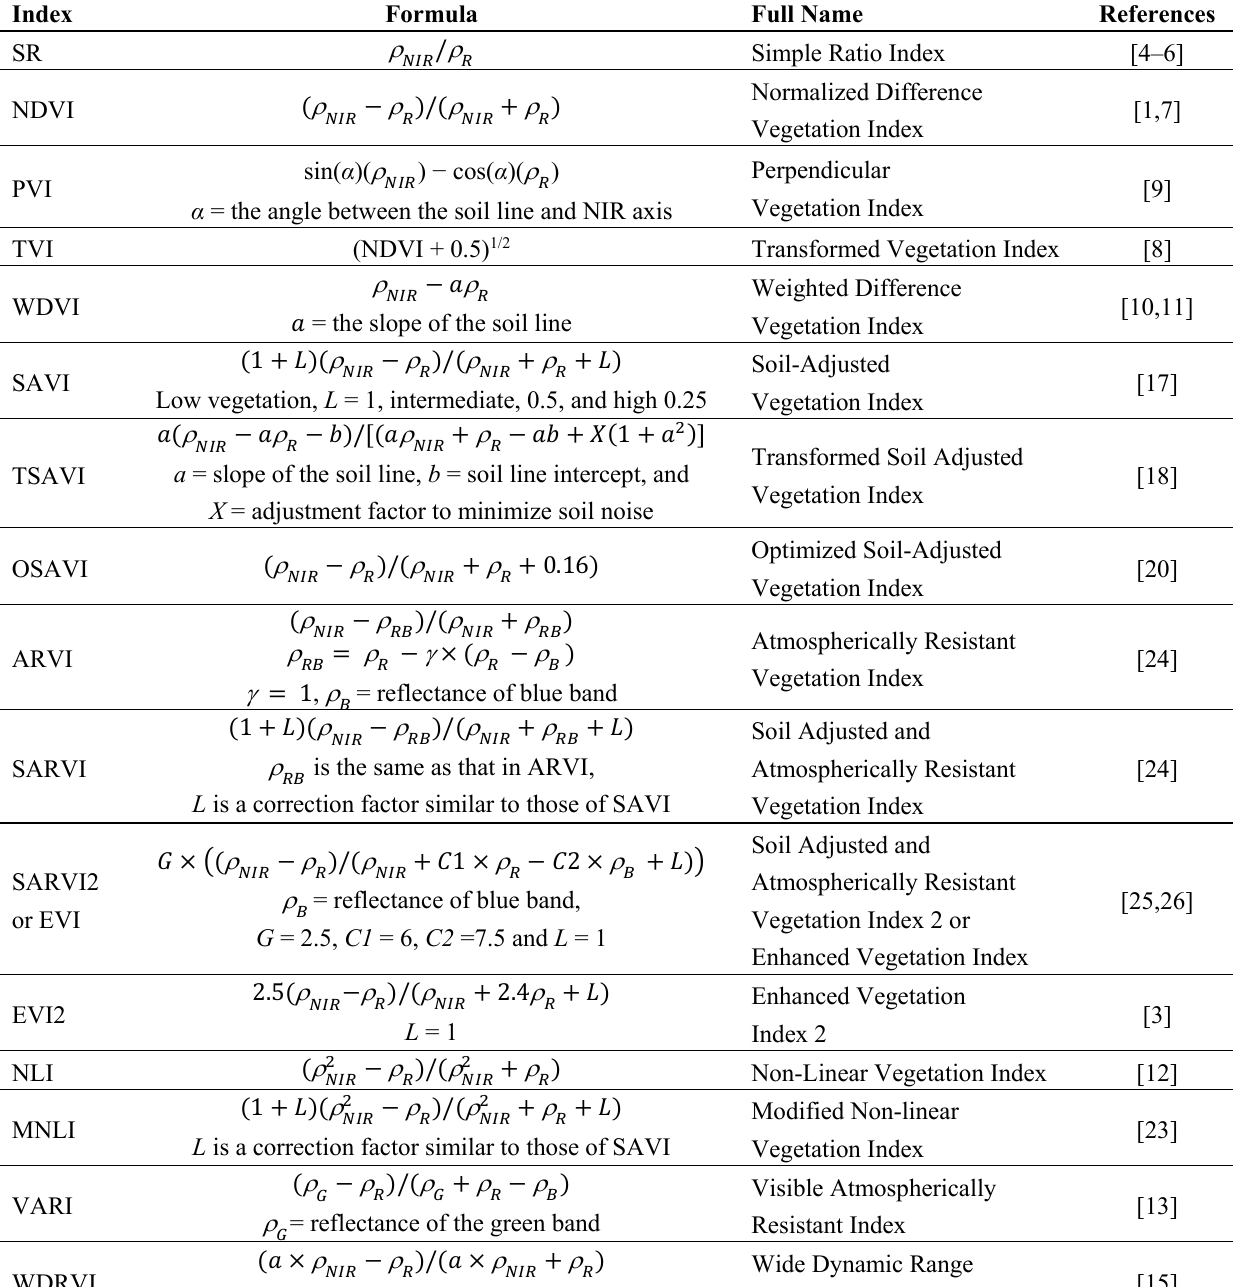
Table 1. Frequently applied vegetation indices developed in the past